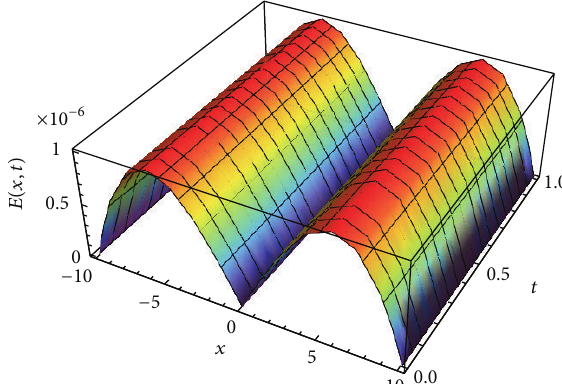
Figure 2: The absolute error between the approximate and the exact solutions of problem (34) with 𝜃 = 𝜗 = −1/2 , 𝜆 1 = 0.01 , 𝜏 = 0.5 , and 𝑁 = 2 .